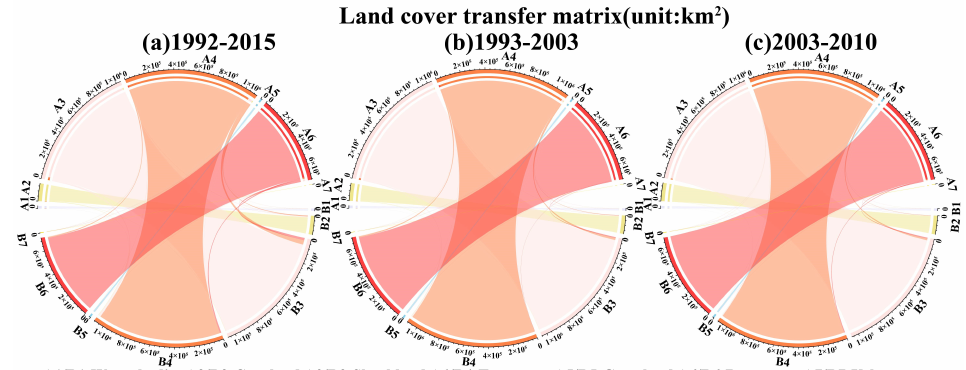
Figure 12. Transfer matrix of land cover for 1992–2015 in the Mongolian Plateau. ( a ) land cover transfer from 1992 to 2015, ( b ) land cover transfer area from 1992 to 2003, ( c ) land cover transfer area from 2003 to 2015.